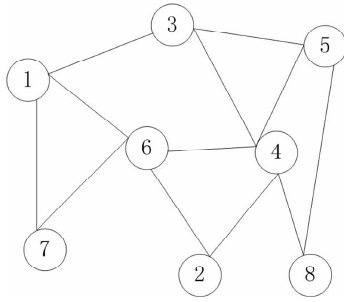
Figure 2. Dominating sets of graph G .